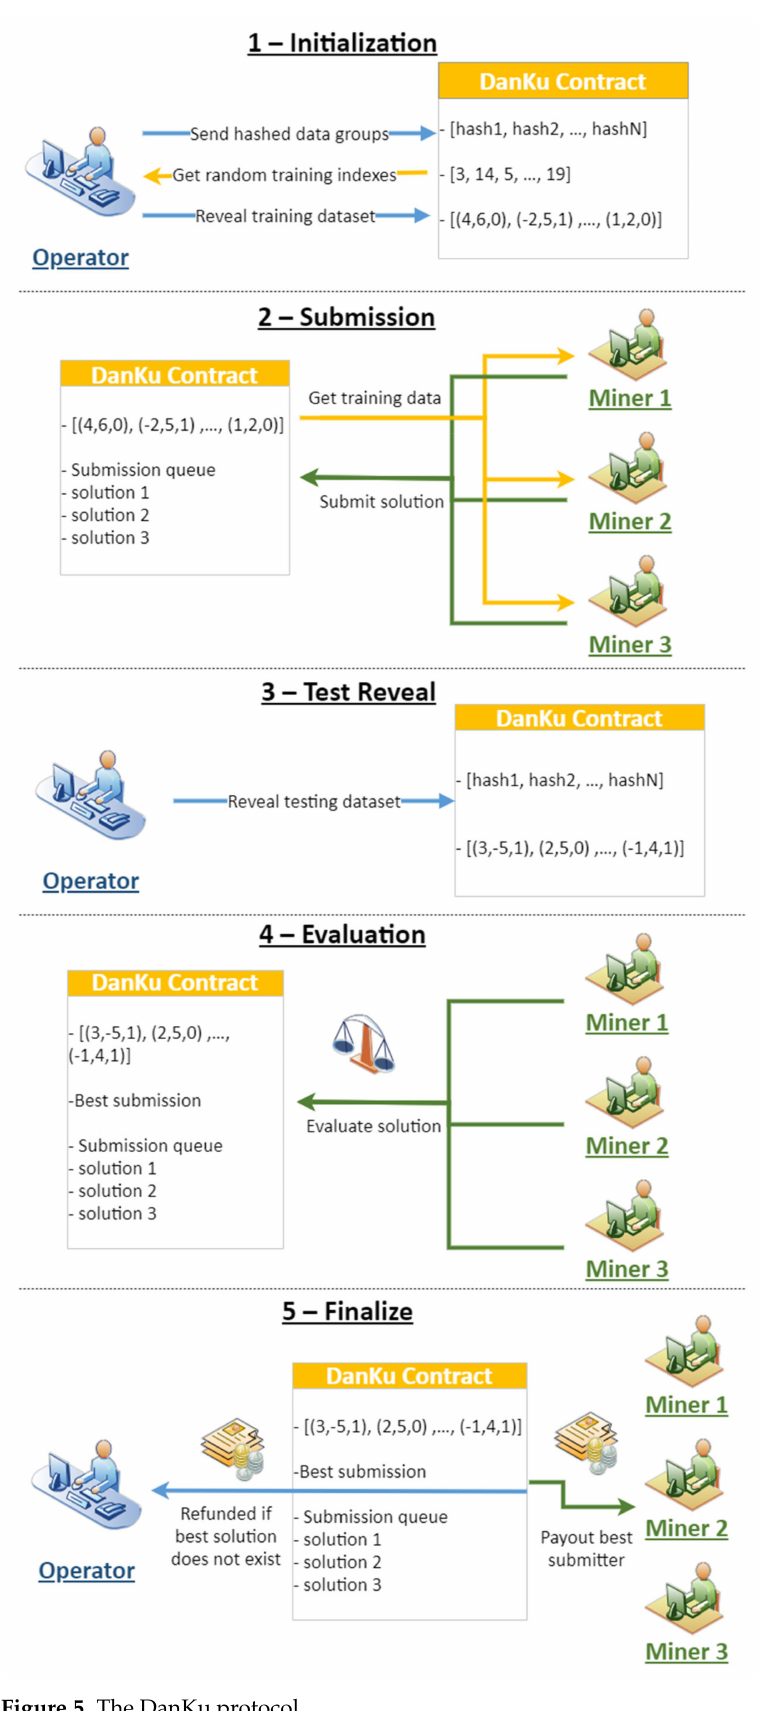
Figure 5. The DanKu